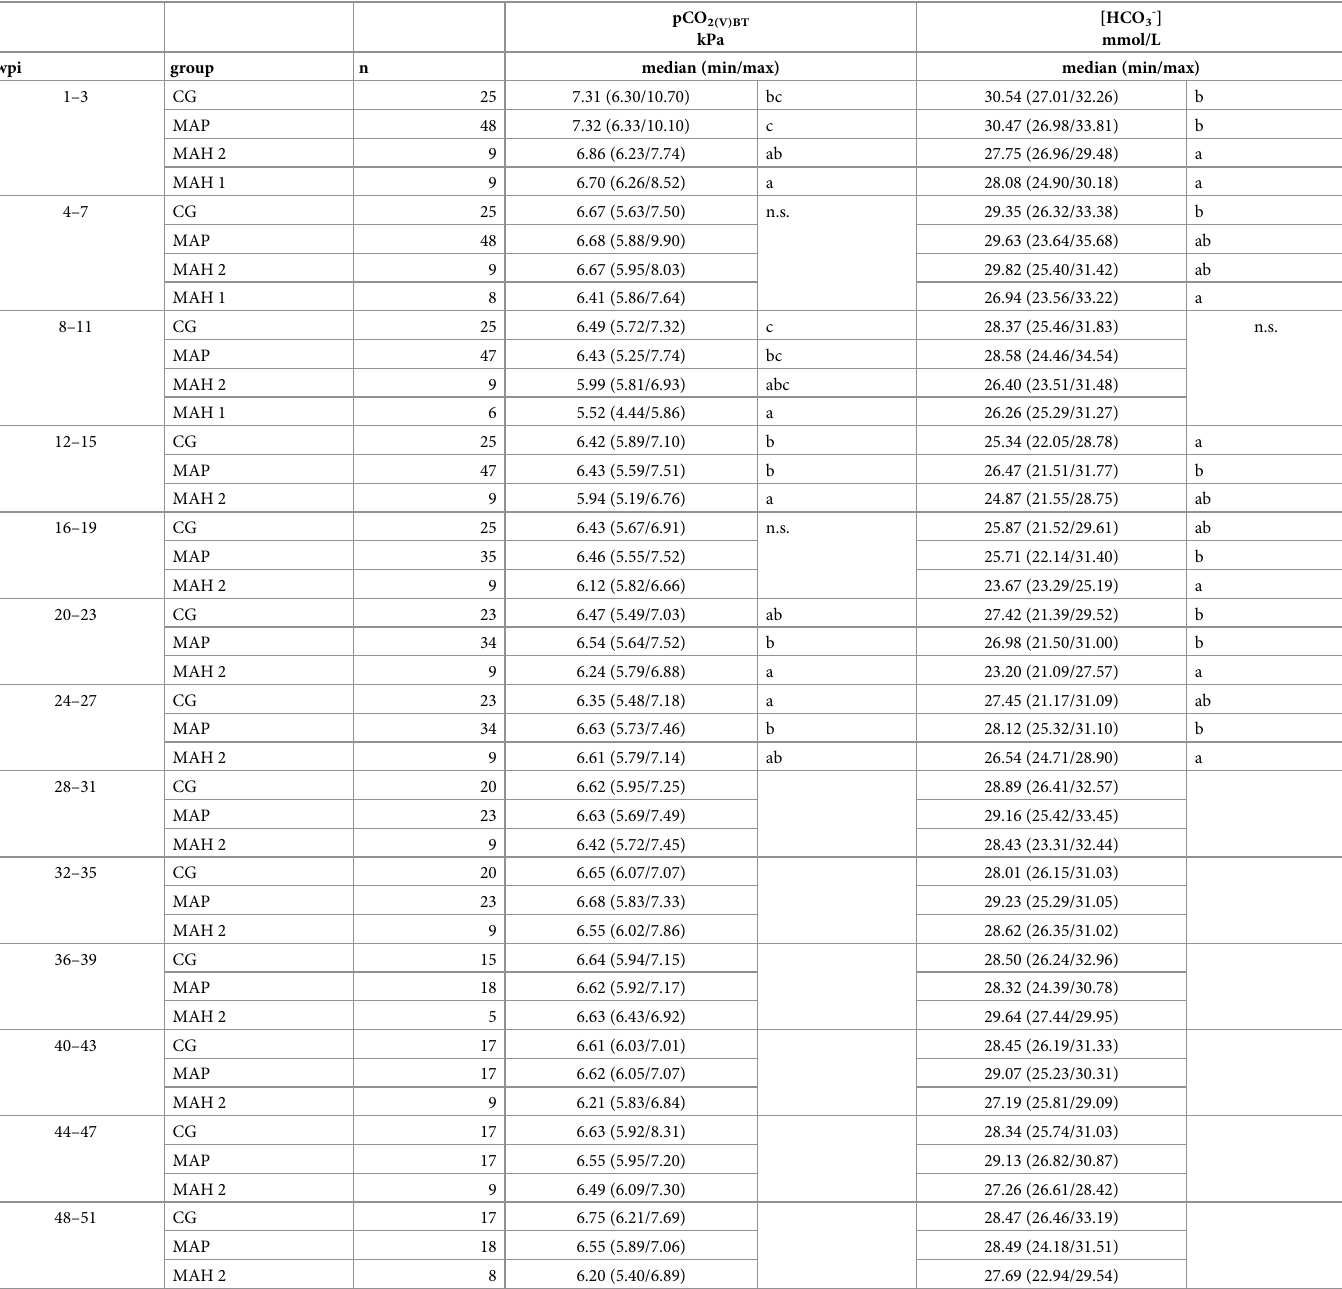
Table 3. Concentration of calculated bicarbonate and measured partial CO 2 pressure (corrected for body temperature) assessed in venous